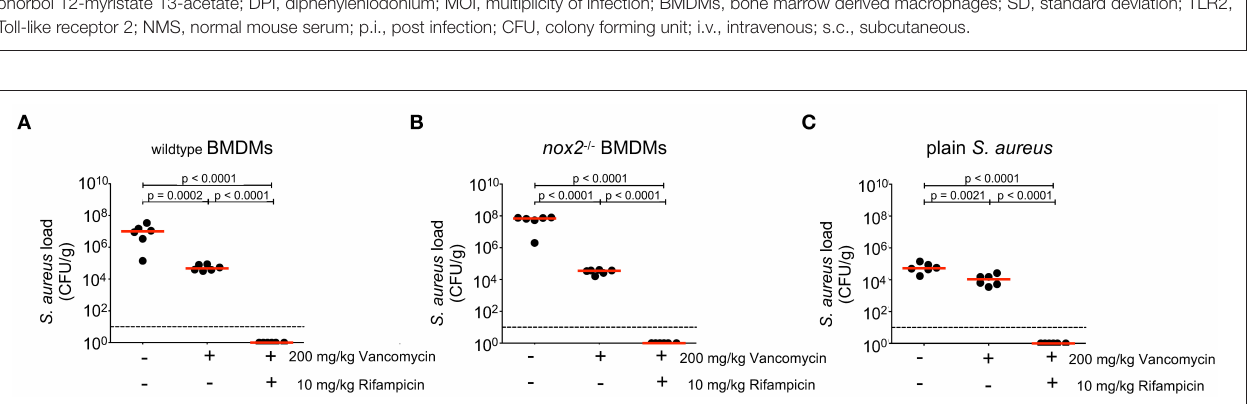
FIGURE 4 | Effects of antibiotic treatment on bacterial load in organs 24h upon injection of BMDM infected with S. aureus . BMDM of (A) wildtype or (B) nox2 − / − mice were infected with S. aureus MW2 GFP (MOI30). 2.5 × 10 6 infected BMDMs were injected in PBS i.v. into naive C57Bl6J mice ( n = 6 per genotype and treatment). (C) Mice injected with 4 × 10 6 plain S. aureus MW2 GFP, corresponding to the CFU recovered from infected BMDM ( n = 6 per treatment). 200 mg/kg vancomycin was injected s.c. either alone or in combination with 10 mg/kg Rifampicin at 1h, 6h, 24h, and 30h after i.v. infection. At 48h p.i. livers of infected mice were homogenized and plated on Mueller-Hinton plates. Shown are individual values for each liver in CFU/g. Red line indicates median, dashed line represents limit of detection. Student’s t -test was performed on log-transformed values. NOX, NADPH Oxidas; ROS, reactive oxygen species; PMA, phorbol 12-myristate 13-acetate; DPI, diphenyleniodonium; MOI, multiplicity of infection; BMDMs, bone marrow derived macrophages; SD, standard deviation; TLR2, Toll-like receptor 2; NMS, normal mouse serum; p.i., post infection; CFU, colony forming unit; i.v., intravenous; s.c.,